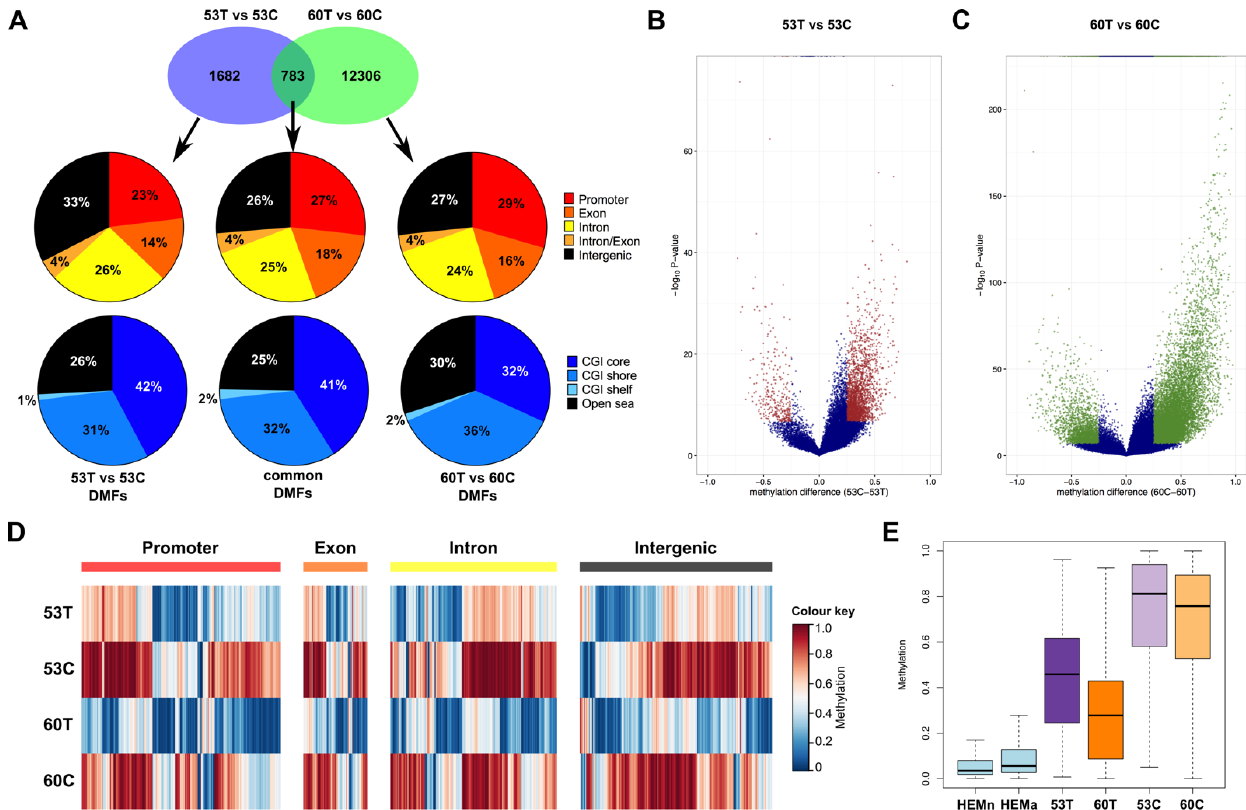
Figure 3. Differential methylation patterns in melanoma tissues and derived cell lines. ( A ) The Venn diagram shows the number of significantly differentially methylated fragments (DMFs) in each comparison (Fisher’s exact test; Bonferroni- adjusted p < 0.01, methylation difference ≥ 25%) and the 783 that were in common. The pie charts show the proportion of DMFs overlapping: (top) gene promoters ( − 2 kb to +1 kb from the TSS), exons, introns, intron/exon junctions and intergenic elements (>2 kb upstream from the nearest TSS); and (bottom) CpG island (CGI) cores, shores, shelfs and open sea. ( B , C ) Volcano plots showing the methylation changes of tissue vs. cell line. The x axis shows methylation differences of the analysed fragments and the y axis shows the − log10 of the p -values. Blue data points indicate fragments that were not significant and DMFs are shown in red (for 53T vs. 53C) or green (for 60T vs. 60C). ( D ) Methylation heatmaps of all common DMFs in different genomic elements (blue = unmethylated, red = fully methylated). ( E ) Boxplots show the methylation distribution of DMFs in normal melanocyte cell lines (light blue), 53T, 53C (purple), 60T and 60C (orange).